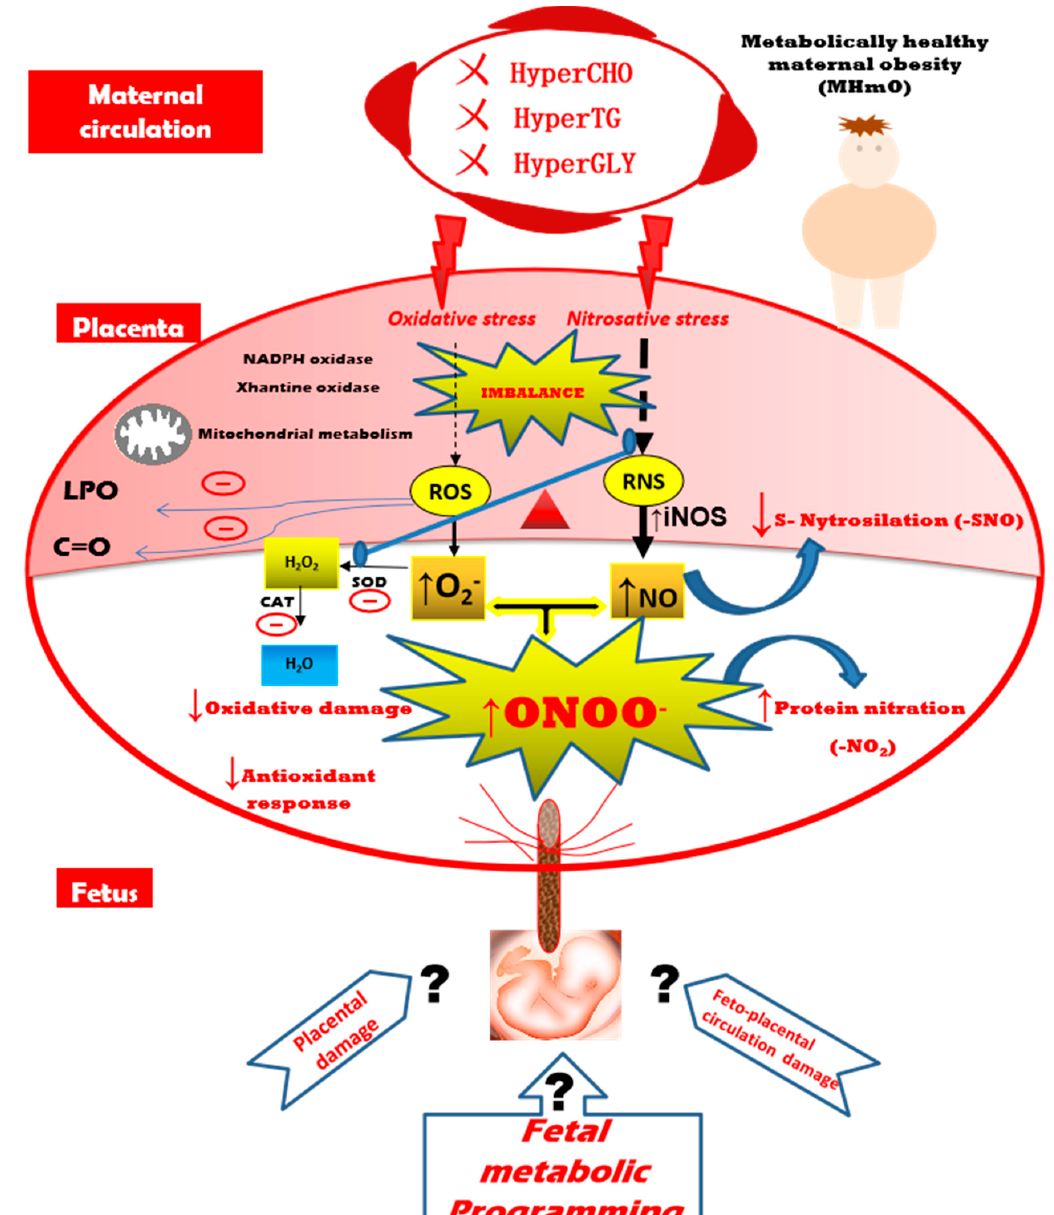
Figure 5. Proposed model of formation of a placental antioxidant/ROS/RNS unit imbalance in pregnancy with metabollicaly healthy maternal obesity. ROS: reactive oxygen species; RNS: